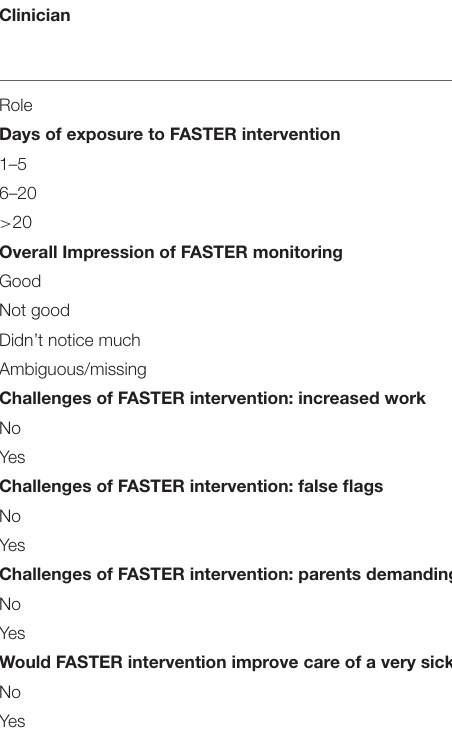
TABLE 2 | Clinician survey of FASTER intervention. Clinician Physician Nurse Clinical officer